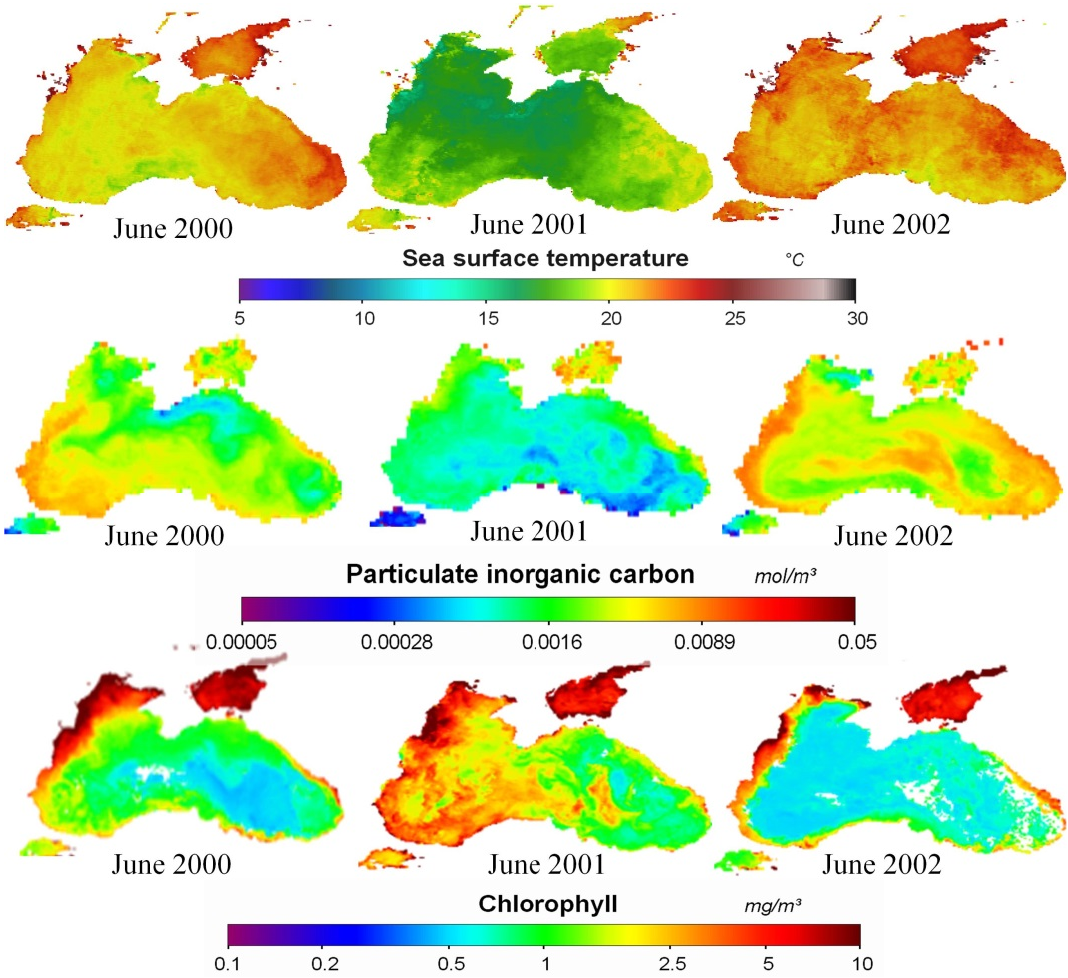
Figure 6. Changes in surface temperature, PIC, and chlorophyll in June 2000–2002.